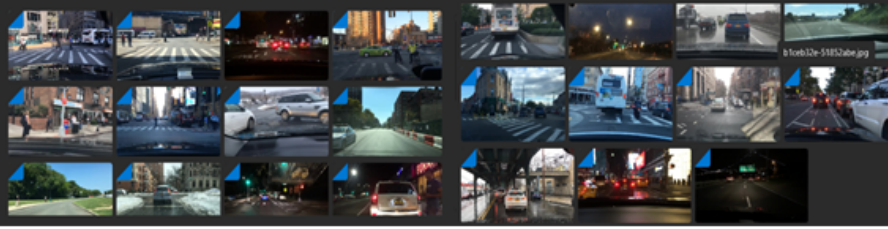
Figure 6. A snapshot of several images from the BDD100K